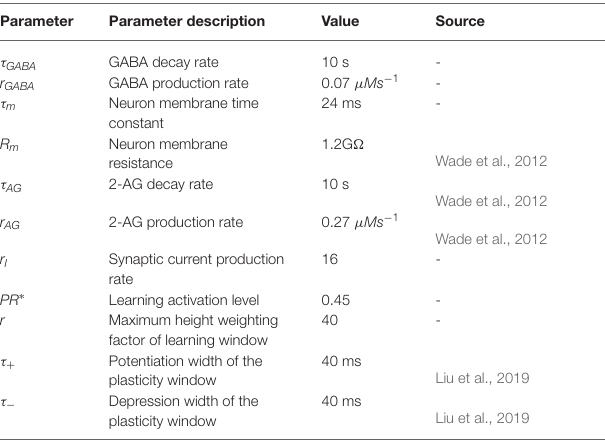
TABLE A1 | GABA interneuron, neuron, and synapse parameters. Parameter